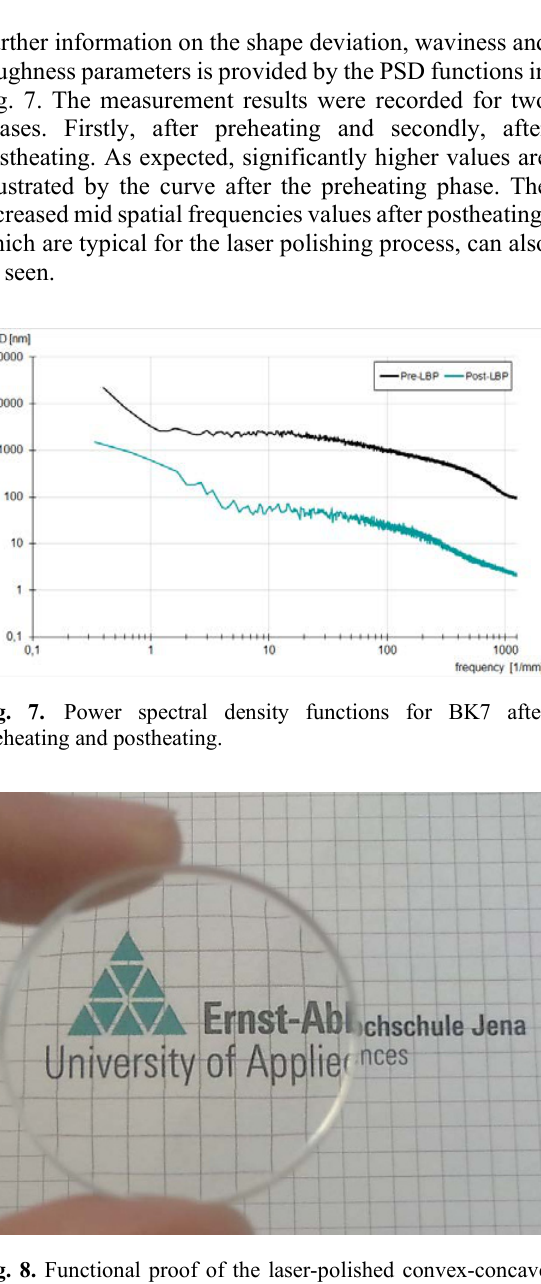
Fig. 8. Functional proof of the laser-polished convex-concave